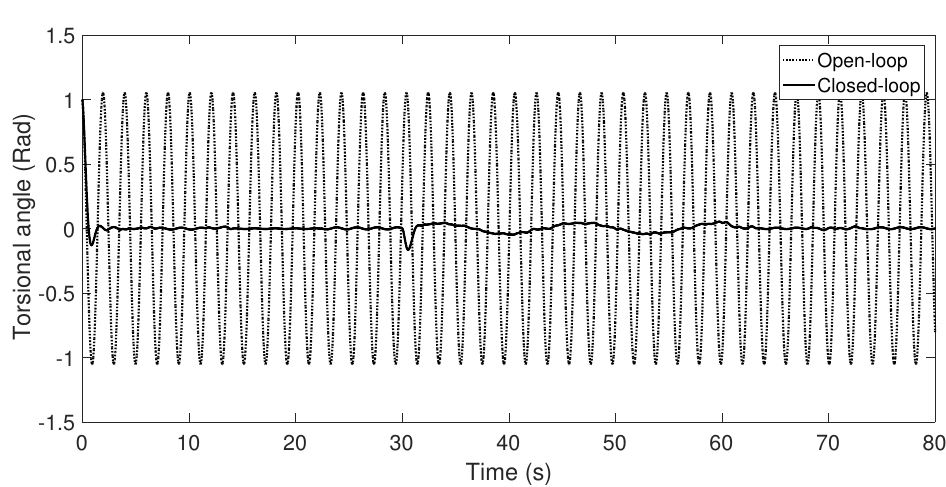
Figure 7. Numerical experiments: Noisy control signal.